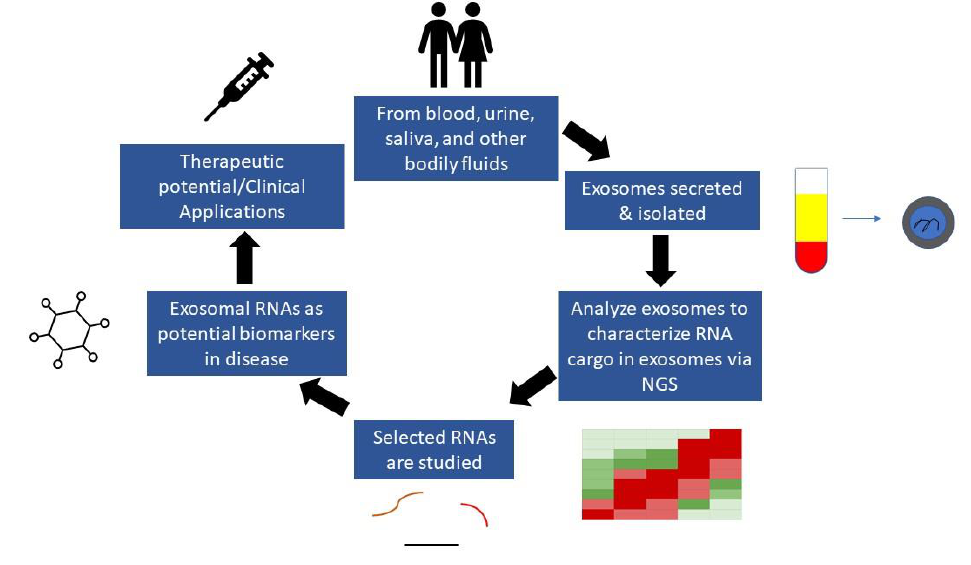
Figure 2. Schematic representation detailing the discovery of biomarkers from exosomes. They are found in and isolated from bodily fluids. The various RNA species from these exosomes are subjected to RNA seq using next-generation sequencing (NGS) to identify potential biomarkers for clinical applications.